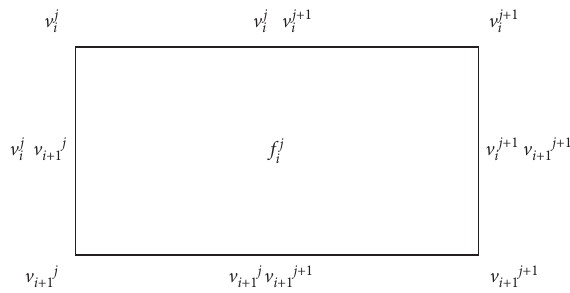
Figure 1: Construction of weights over the face f under k -labeling of type (1, 1, � 1 , for every value of j, k 􏼦 􏼧 − 1 and j � 1 , 2 , . . . , m + 1 , For i � 2 ( m + 1 ) /3 ⌊ ⌋